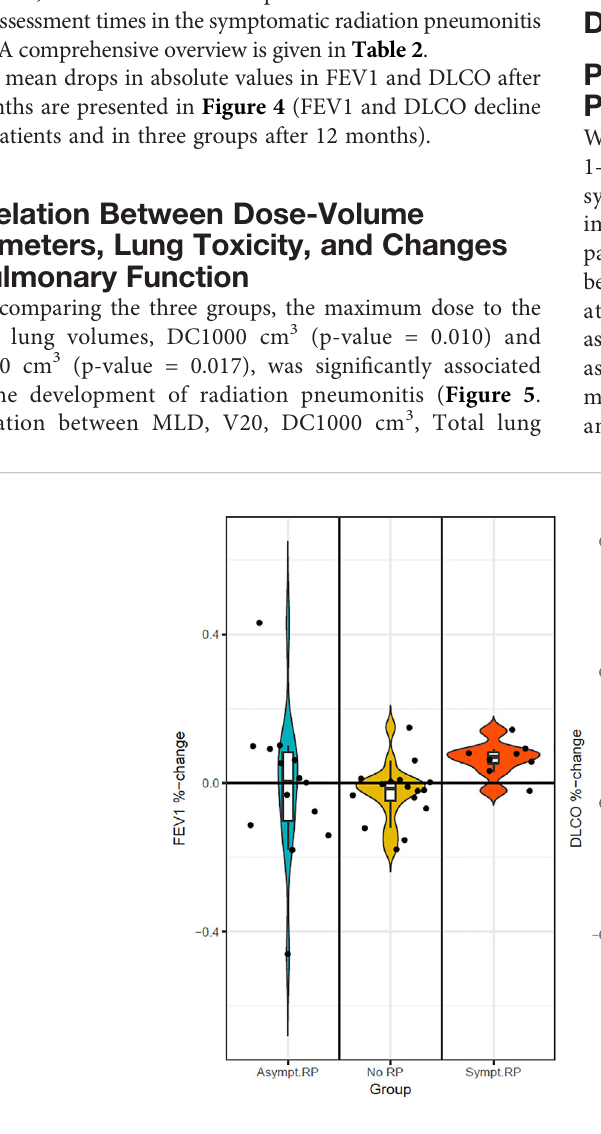
FIGURE 2 | FEV1 and DLCO in percent changes in three groups at 1 – 1.5